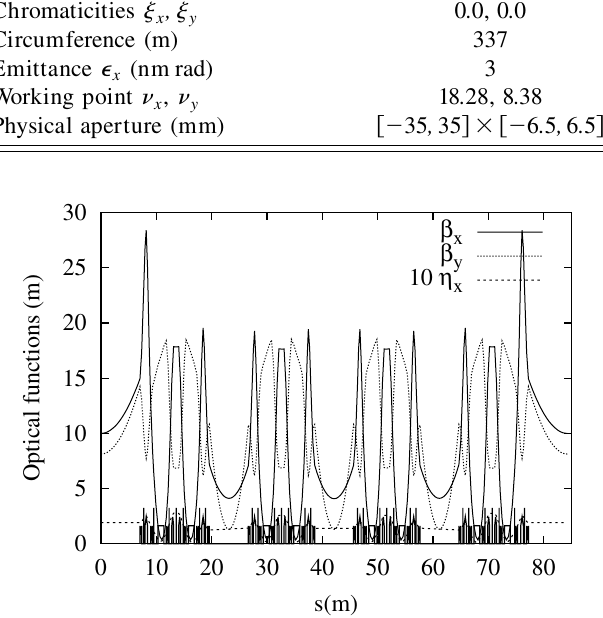
FIG. 3. Optical functions for one of the four SOLEIL super- periods composed of two double bend achromat cells.